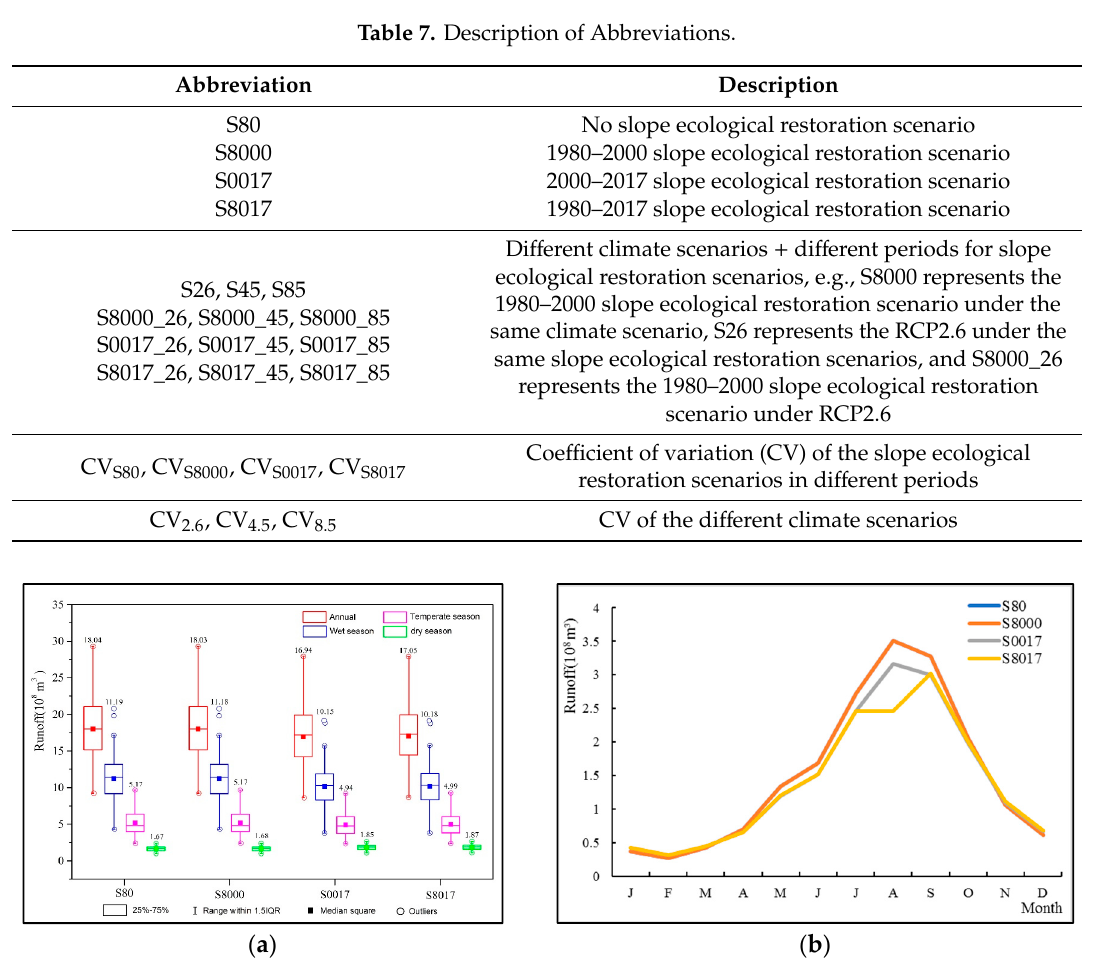
Table 7. Description of Abbreviations.